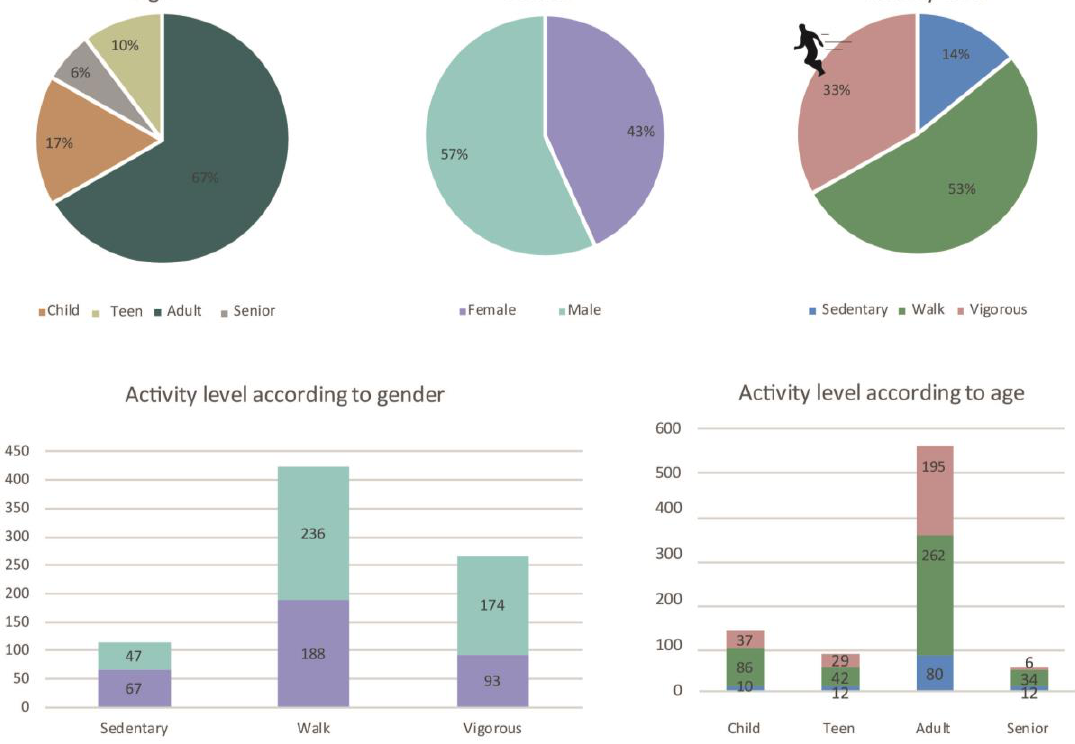
Figure 3. Observed age, gender and activity level on Lüders parking roof.